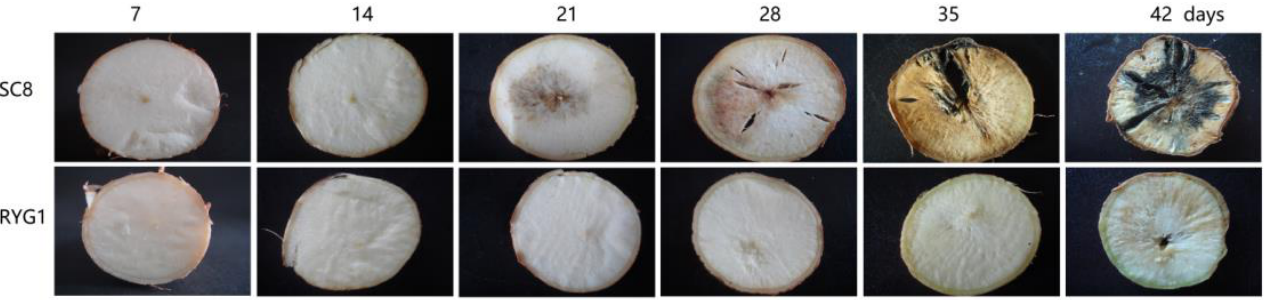
Figure 1. PPD detection results for the SC8 and RYG1 cassavas after the proximal and distal ends were removed.